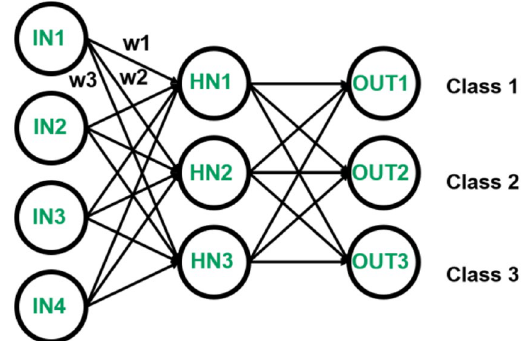
Figure 7. Graph representation of the perceptron with four input nodes, three hidden neurons, and three output classes. Not shown in the figure is the bias which has a value of 1 as an input and a weight connected to each hidden and output node.